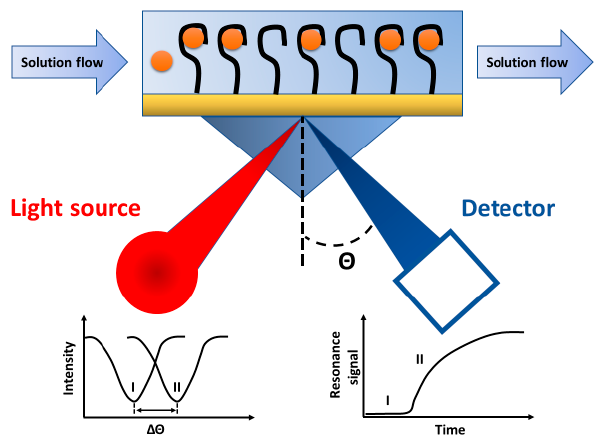
Figure 8. The scheme of the SPR set-up. Aptamers are immobilized at the gold layer sputtered on a glass prism. The binding of the analyte with aptamers resulted in the shift of the resonant angle. Adopted from [184] with permission of Elsevier.